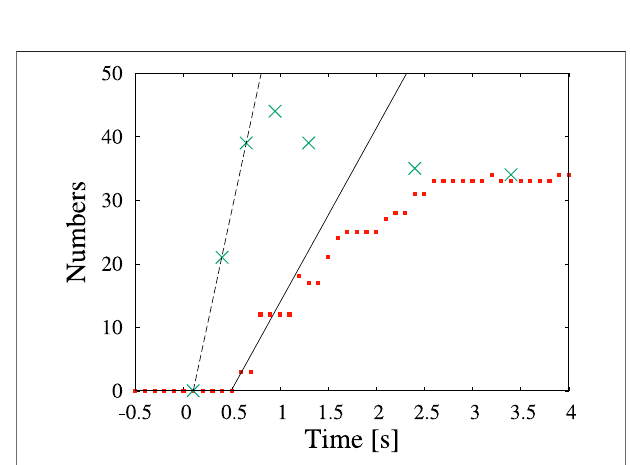
FIGURE5| Timechangeinthenumberofparticlescountedbydetection (red squares) and by the human eye (green cross) in Figure 4 . The time of 0 s corresponds to the start of